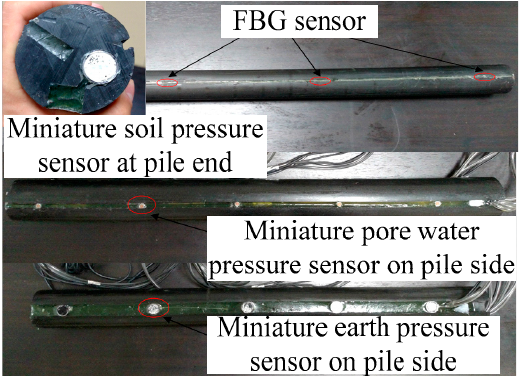
Figure 10. Sensor installation.